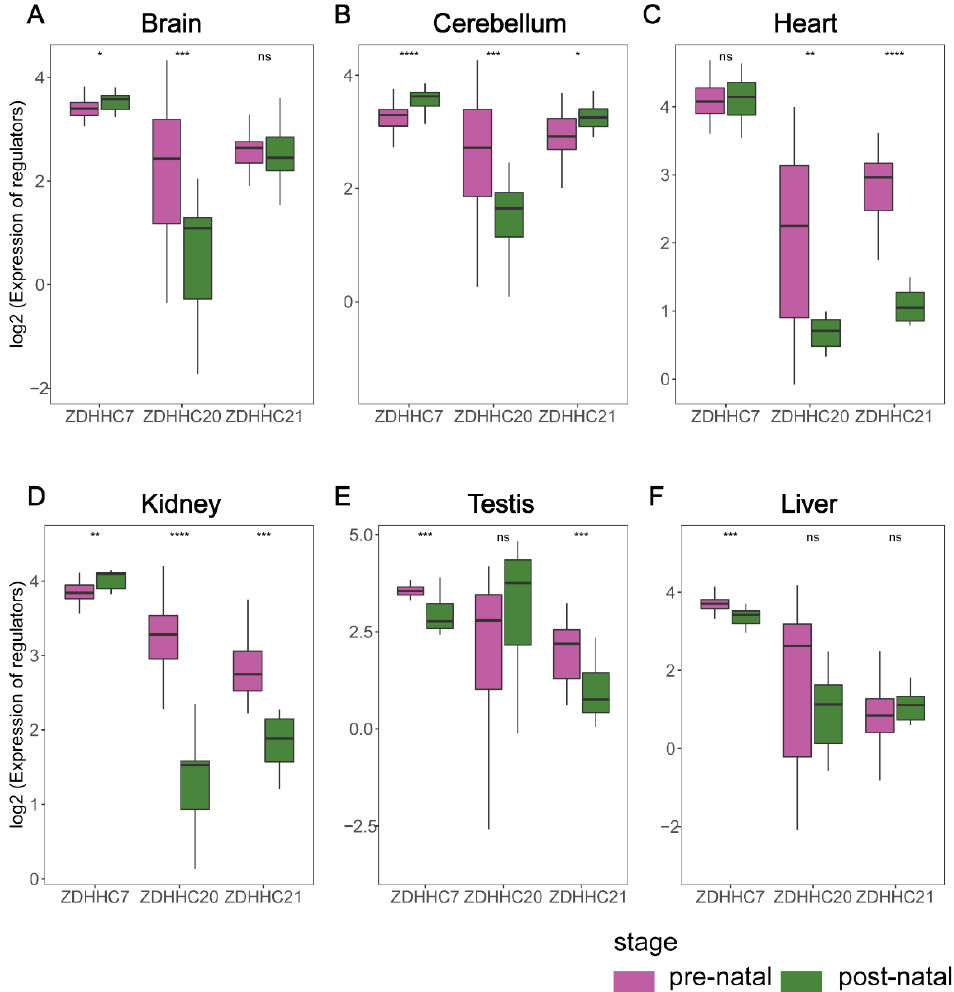
Figure 2. Boxplots exhibiting the expression of ZDHHC7/20/21 in prenatal and postnatal samples of different organs. ( A ) Expression of ZDHHC7/20/21 in the brain. ( B ) Expression of ZDHHC7/20/21 in the cerebellum. ( C ) Expression of ZDHHC7/20/21 in the heart. ( D ) Expression of ZDHHC7/20/21 in the kidney. ( E ) Expression of ZDHHC7/20/21 in testis. ( F ) Expression of ZDHHC7/20/21 in the liver. * indicates p < 0.05. ** indicates p < 0.01. *** indicates p < 0.001. “ns” represents non-significant.